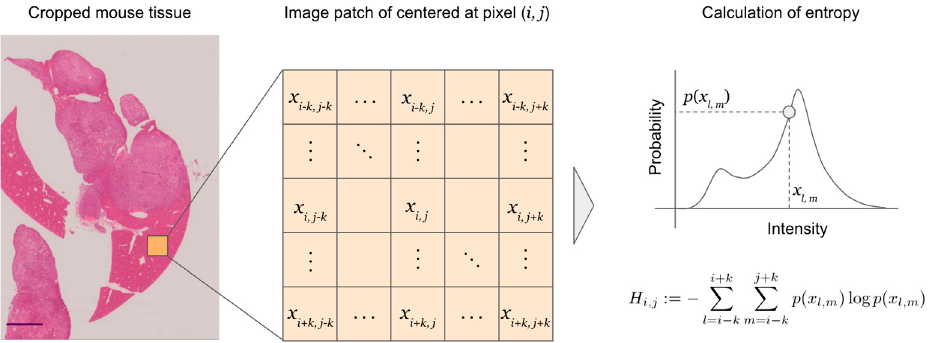
Figure 1. Example of local entropy calculation at pixel ( i, j ) of an image patch centered at pixel ( i, j ). The same calculation is performed on all pixels in the tissue. k was set to 20. Scale bar = 2.0 mm.